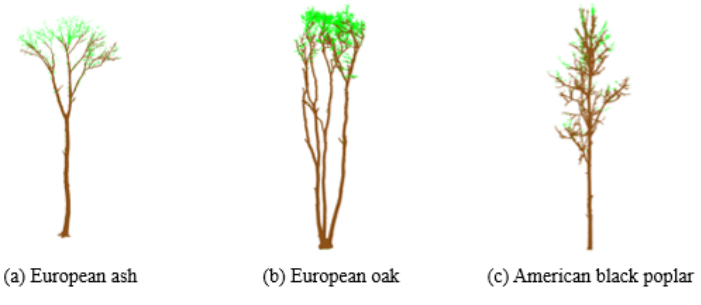
Figure 3. Separation of leaves and